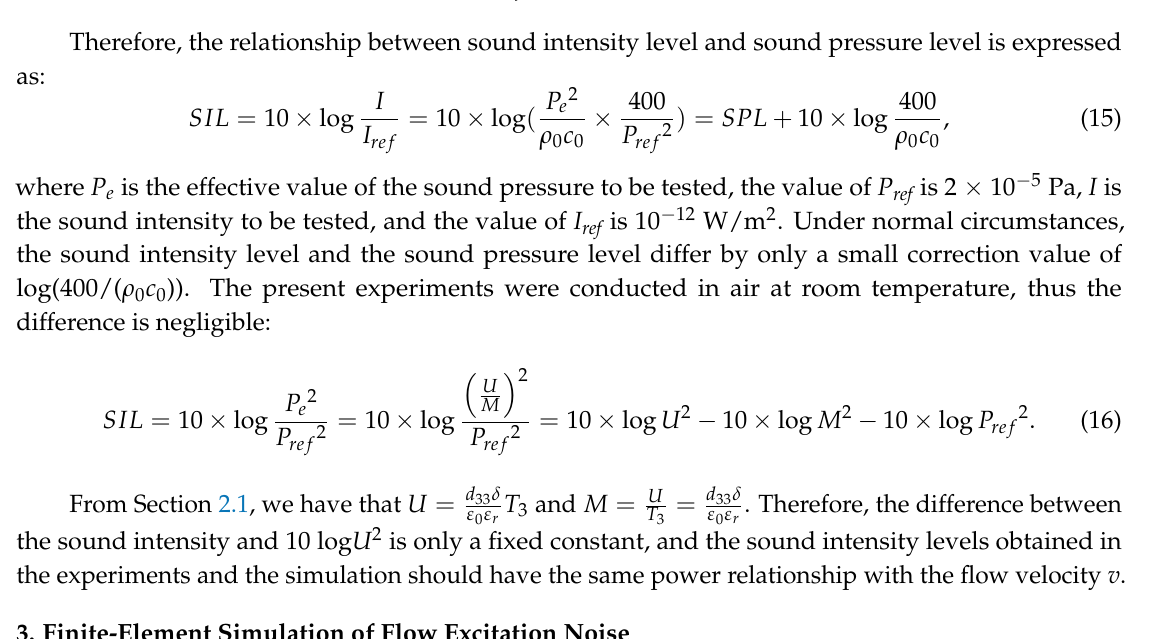
Table 1. Definition of boundary conditions.